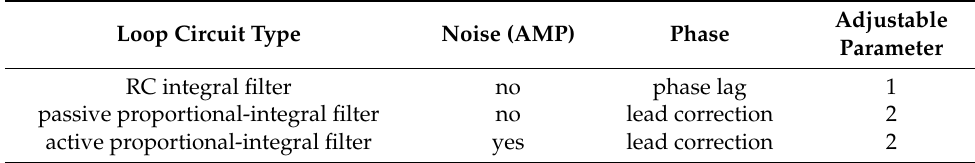
Table 1. Loop filter characteristics